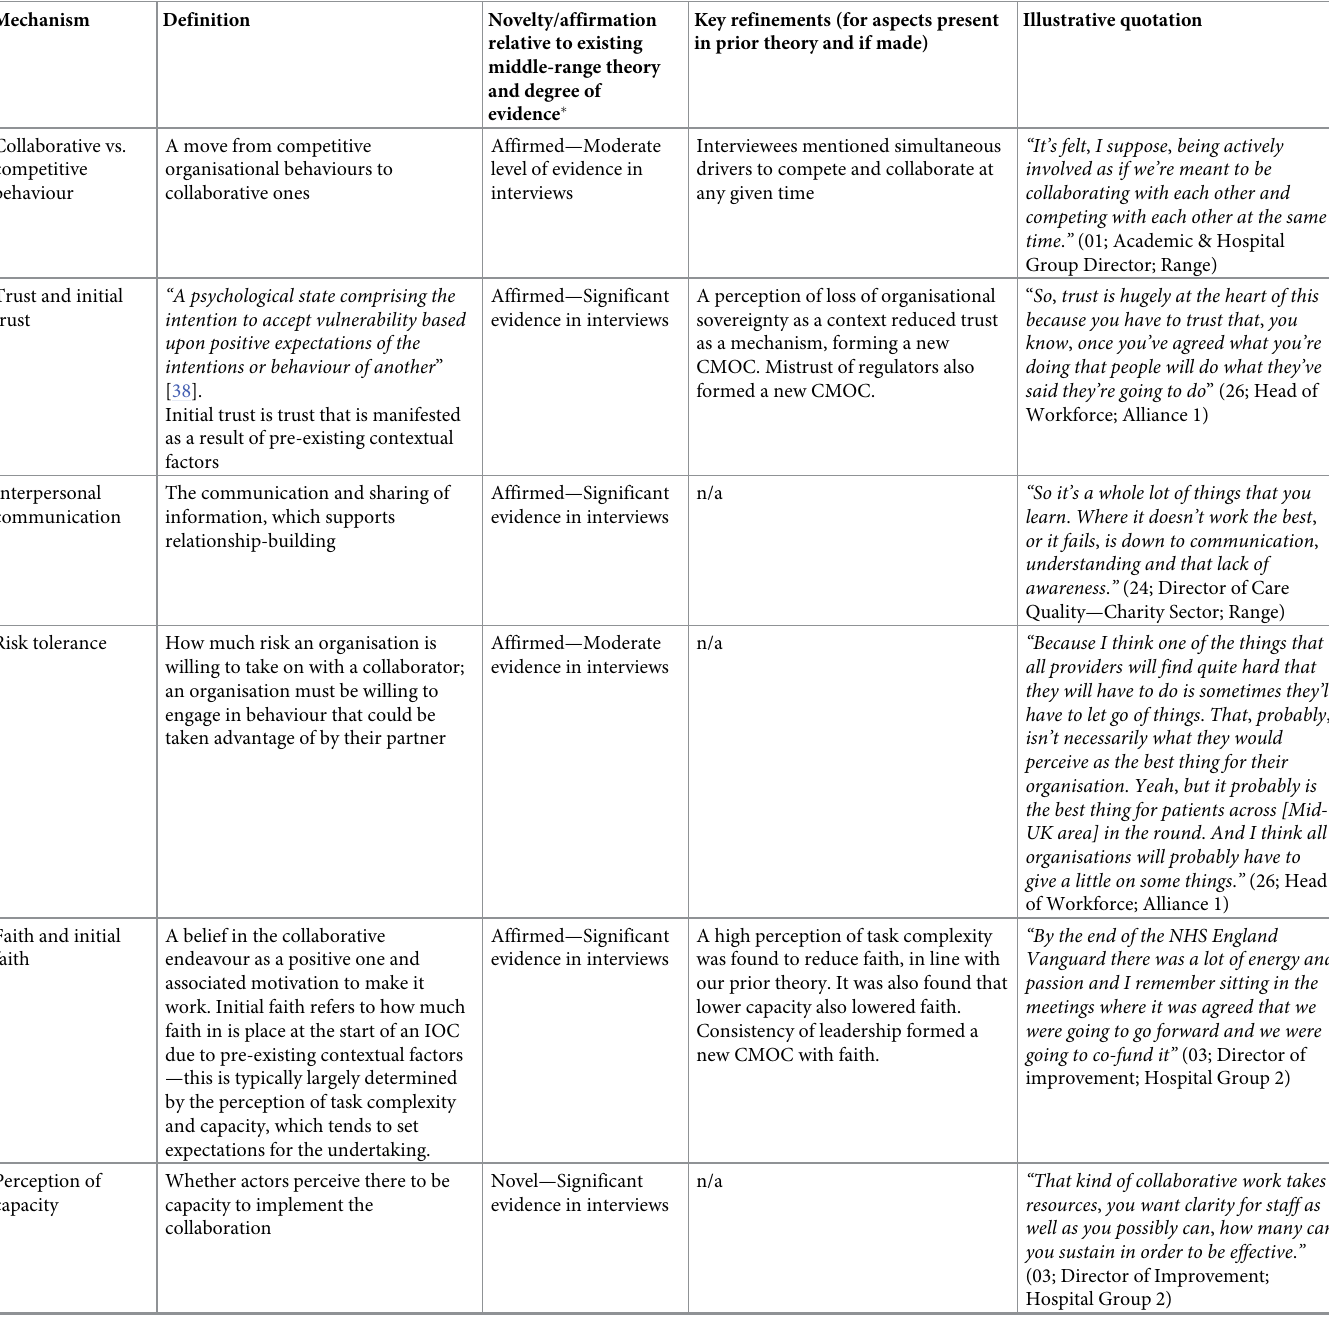
Table 2. Description of mechanisms underlying collaborative functioning, whether they are novel or not, their degree of evidence, what refinements were made, and a supporting